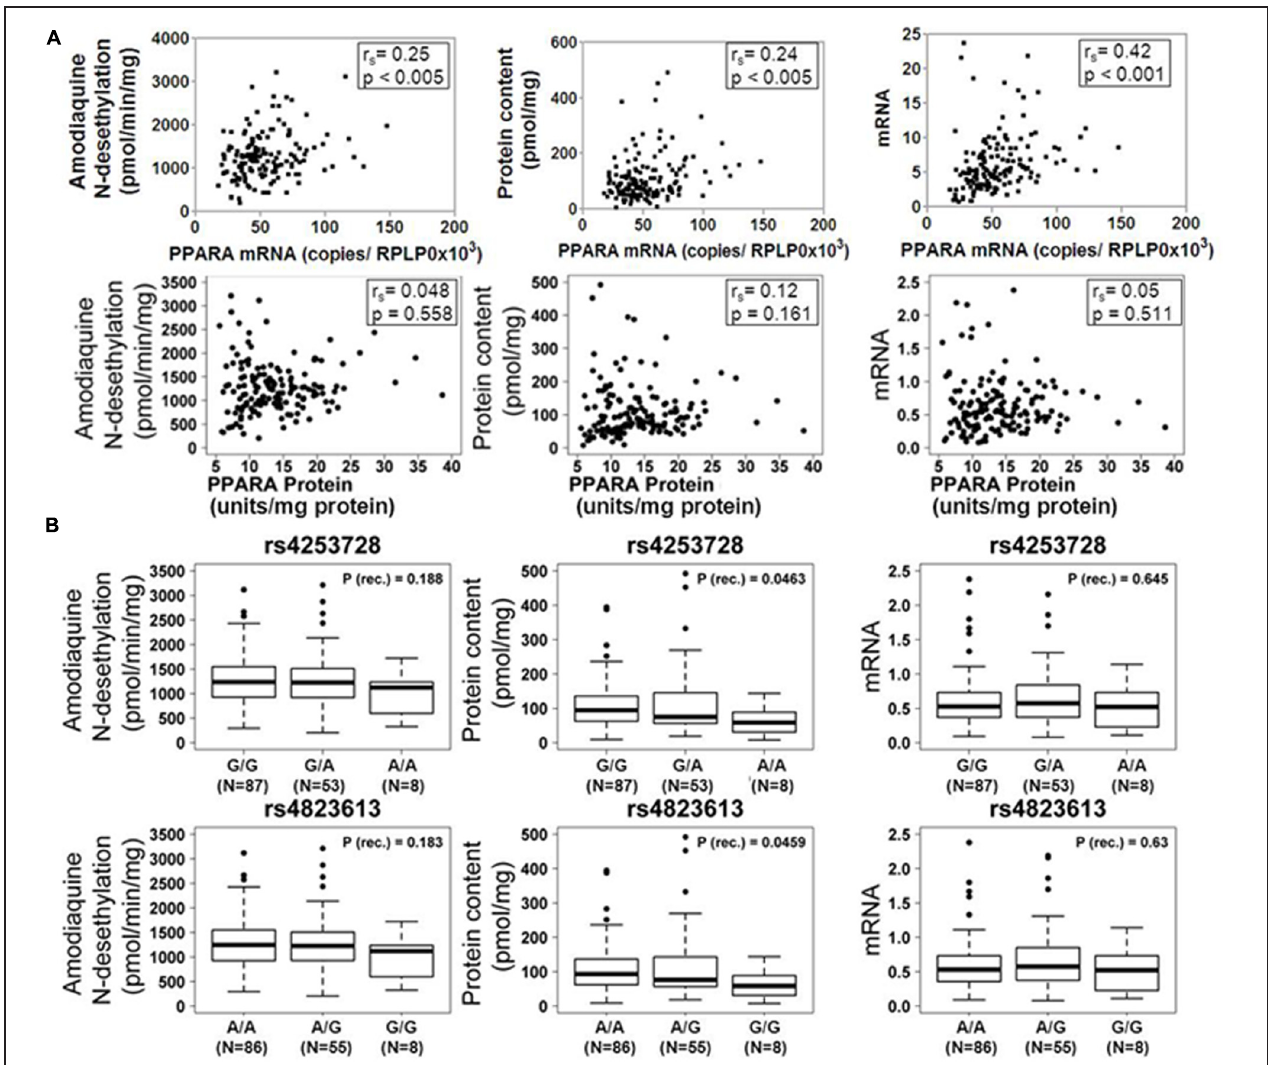
FIGURE 2 | Influence of PPAR α expression and genotype on the CYP2C8 phenotype. (A) Scatter plots of CYP2C8 phenotypes (amodiaquine N-desethylation, CYP2C8 protein and mRNA expression) vs. PPAR α mRNA (top) and protein (bottom) expression. Spearman’s rank correlation coefficient r s and corresponding p -values are given. (B) Box-and-whisker plots of CYP2C8 phenotypes (Amodiaquine N -desethylation, CYP2C8 protein and mRNA expression) for two previously described intronic PPARA variants. Genotypes are indicated as G/G, G/A, and A/A (for rs4253728) and A/A, A/G, and G/G (for rs4823613). P (rec.), unadjusted p -value of Wilcoxon–Mann–Whitney test for recessive genetic model; N, number of individuals per group; numbers for the three genotype groups do not add up to 150 due to missing values. Outliers were included in all